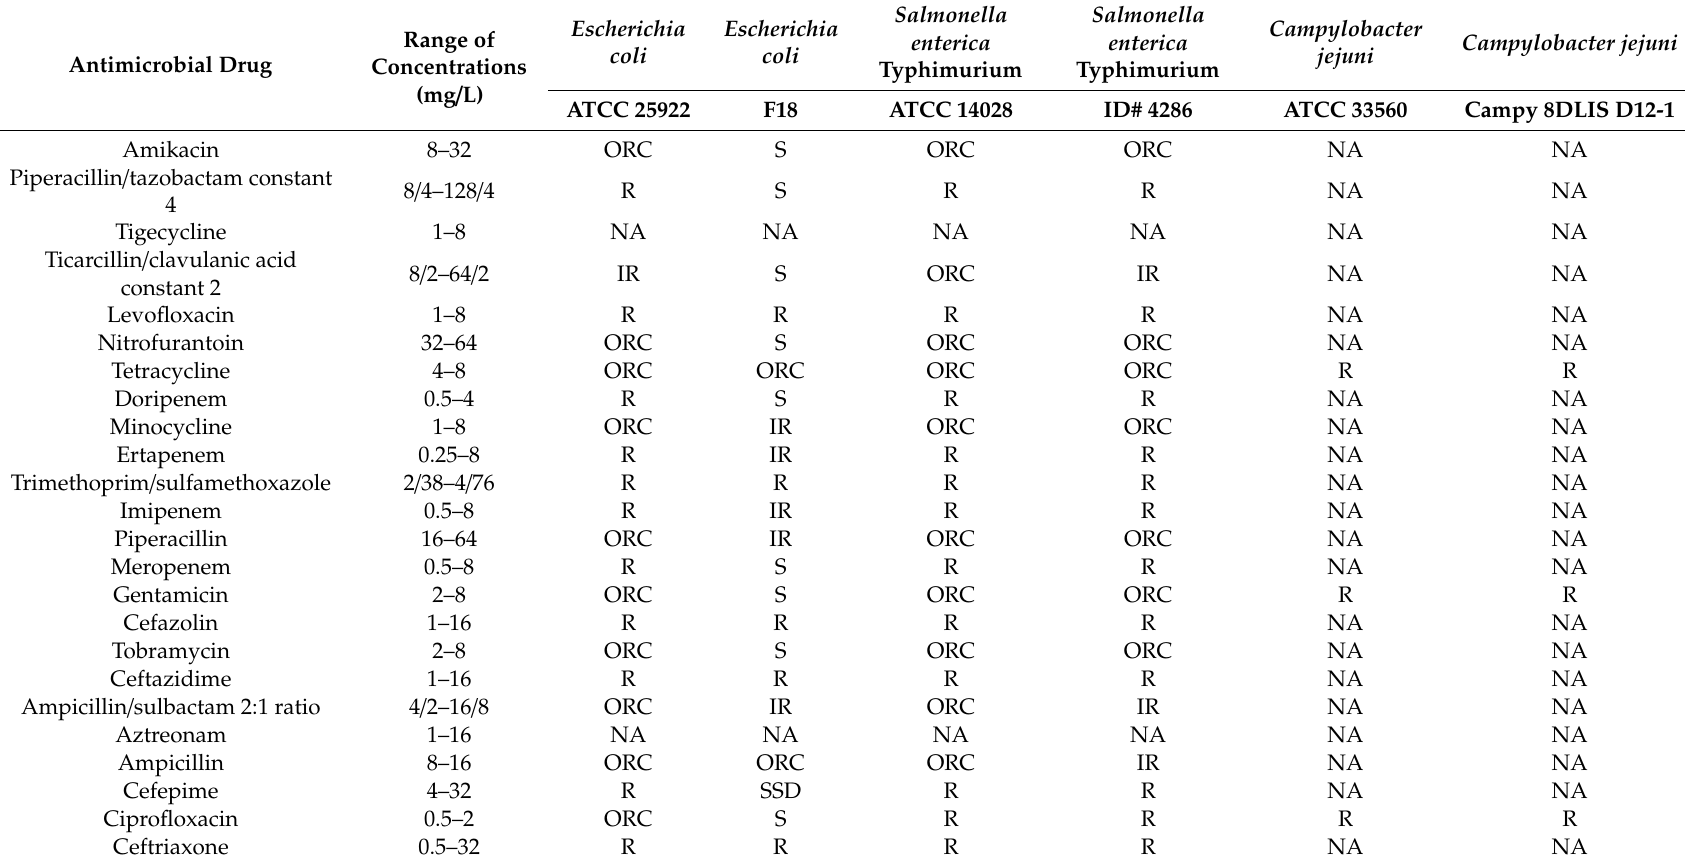
Table 3. Antimicrobial susceptibility of tested G- bacteria